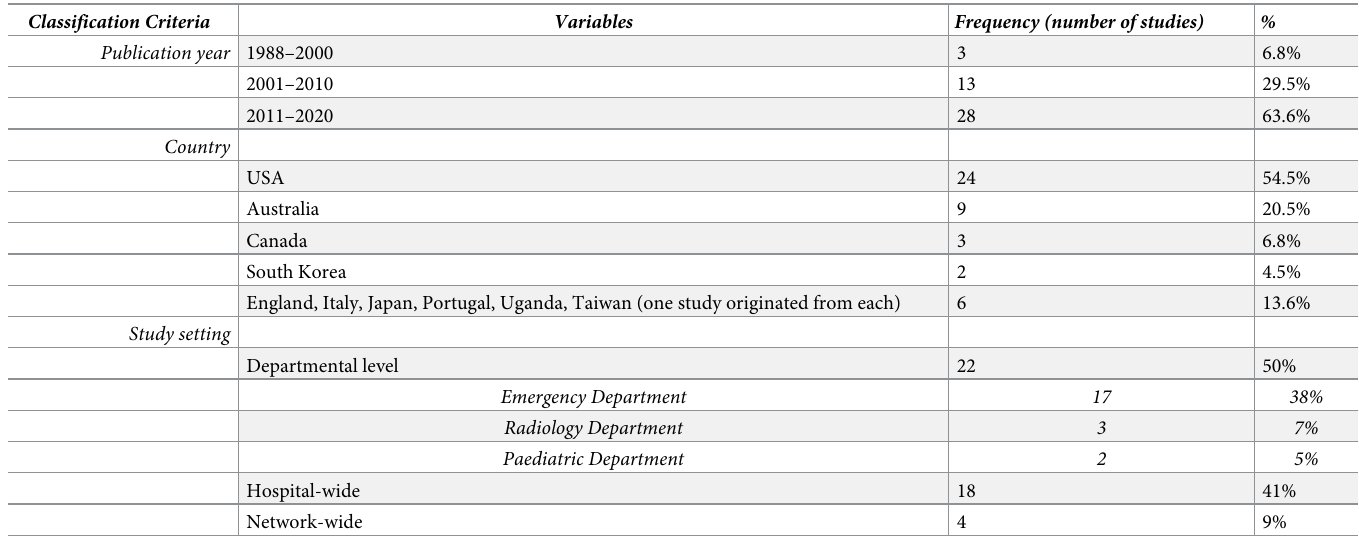
Table 4. Publication and study site profile of included studies.